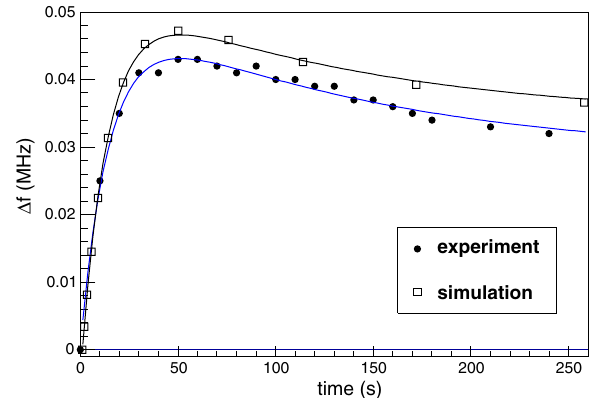
FIG. 10. Transient behavior after the rf power is turned off. The rf power was turned off at t ¼ 0 . The vertical axis is the frequency shift from t ¼ 0 . the simulation. The horizontal axis represents the time after rf is turned off. The vertical axis denotes the fre- quency shift from t ¼ 0 . At that time, T v av was 26 : 29 (cid:1) C